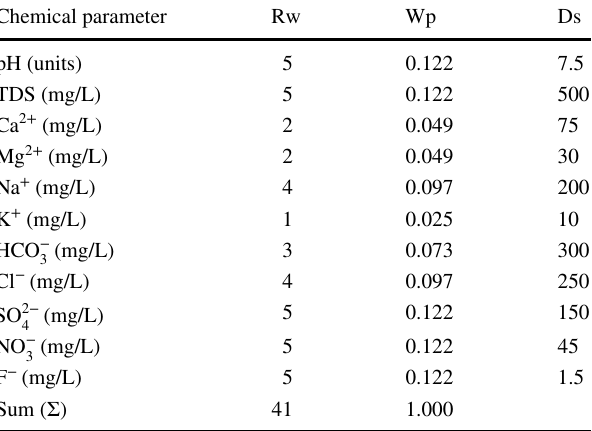
Table 1 Particulars of relative weight (Rw), weight parameter (Wp) and drinking water quality standard (Ds). Source : Subba Rao (2012) Chemical parameter